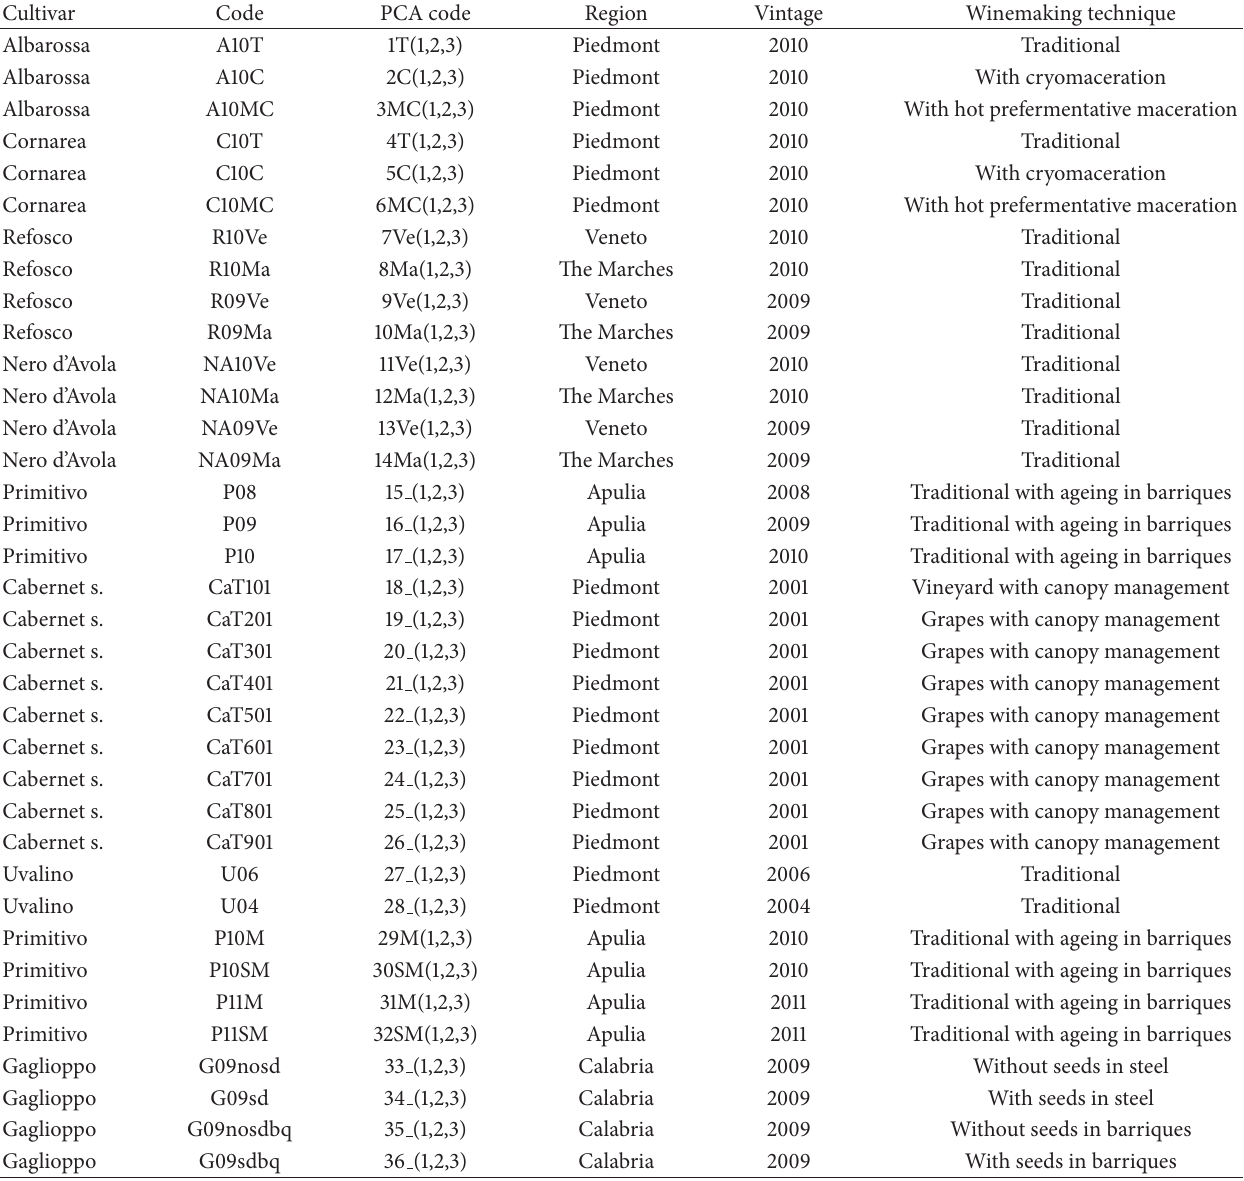
Table 1: An overview of the wine samples